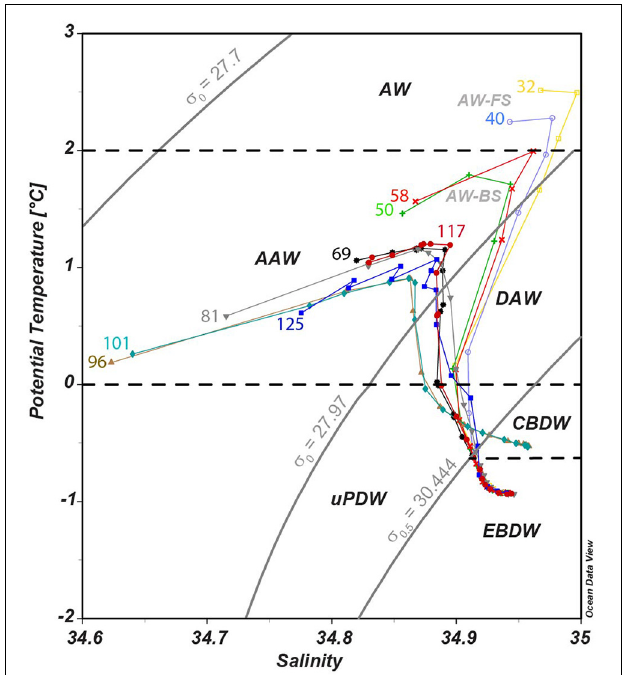
FIGURE 2 | Potential temperature – salinity diagram for all stations from 200 m to the bottom. Solid gray lines are potential density σ 0 and σ 0 . 5 at reference pressure 0 and 500 m, respectively. Black dashed lines represent the water mass definitions based on potential temperature. Water masses are labeled as follows: AW, Atlantic Water; AAW, Arctic Atlantic Water; DAAW, Dense Arctic Atlantic Water; uPDW, Upper Polar Deep Water; EBDW, Eurasian Basin Deep Water; CBDW, Canadian Basin Deep Water.